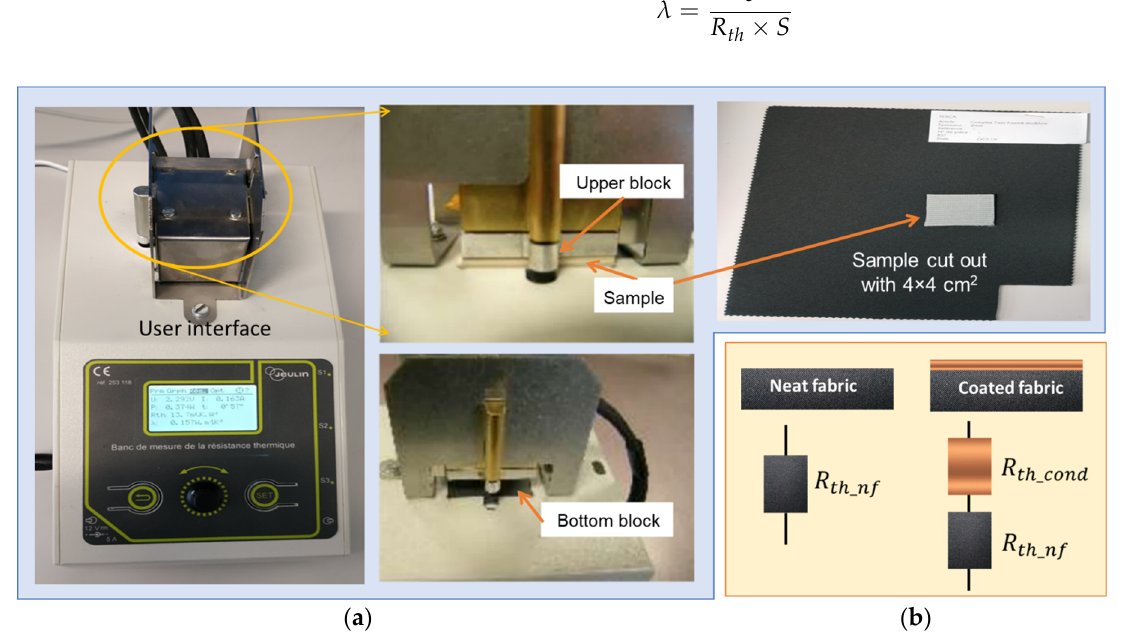
Figure 10. Thermal characterization of fabrics with and without printed coatings: ( a ) Thermal re- sistance measurement using a Jeulin device and ( b ) equivalent scheme of a simple thermal model.